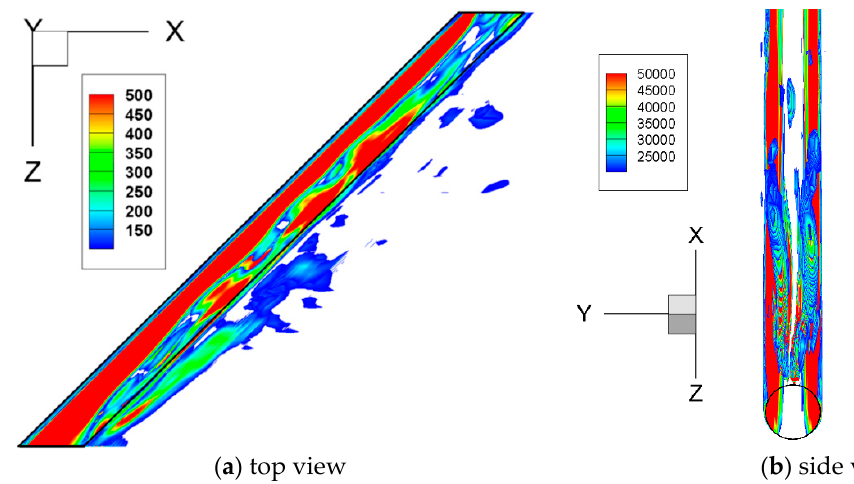
Figure 6. Axial vortices along the cylinder axis at α = 45°.